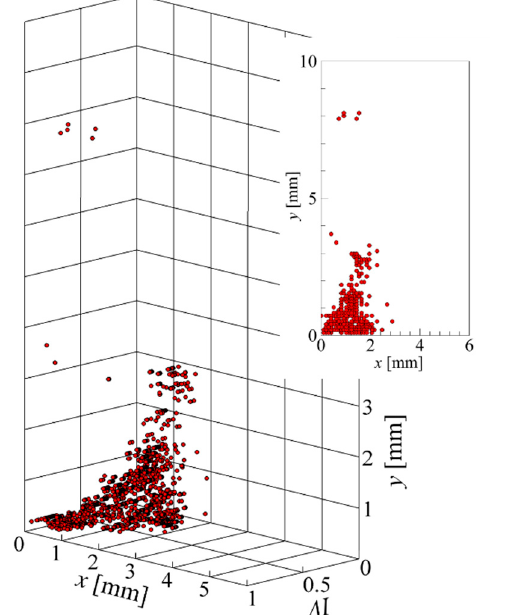
Figure 12. Power spectrum density distribution at 3.6 kHz. The contour level is the same in all figures.